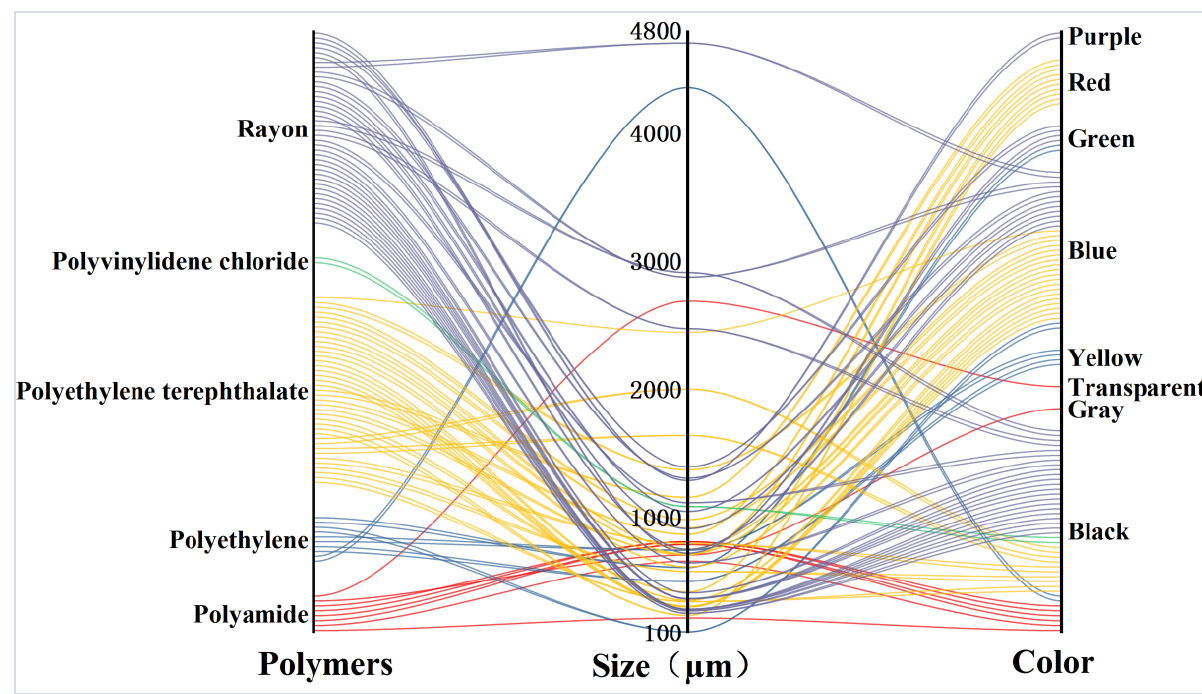
Figure 3. Characteristic information of polymers, particle size, and color of all microplastics.